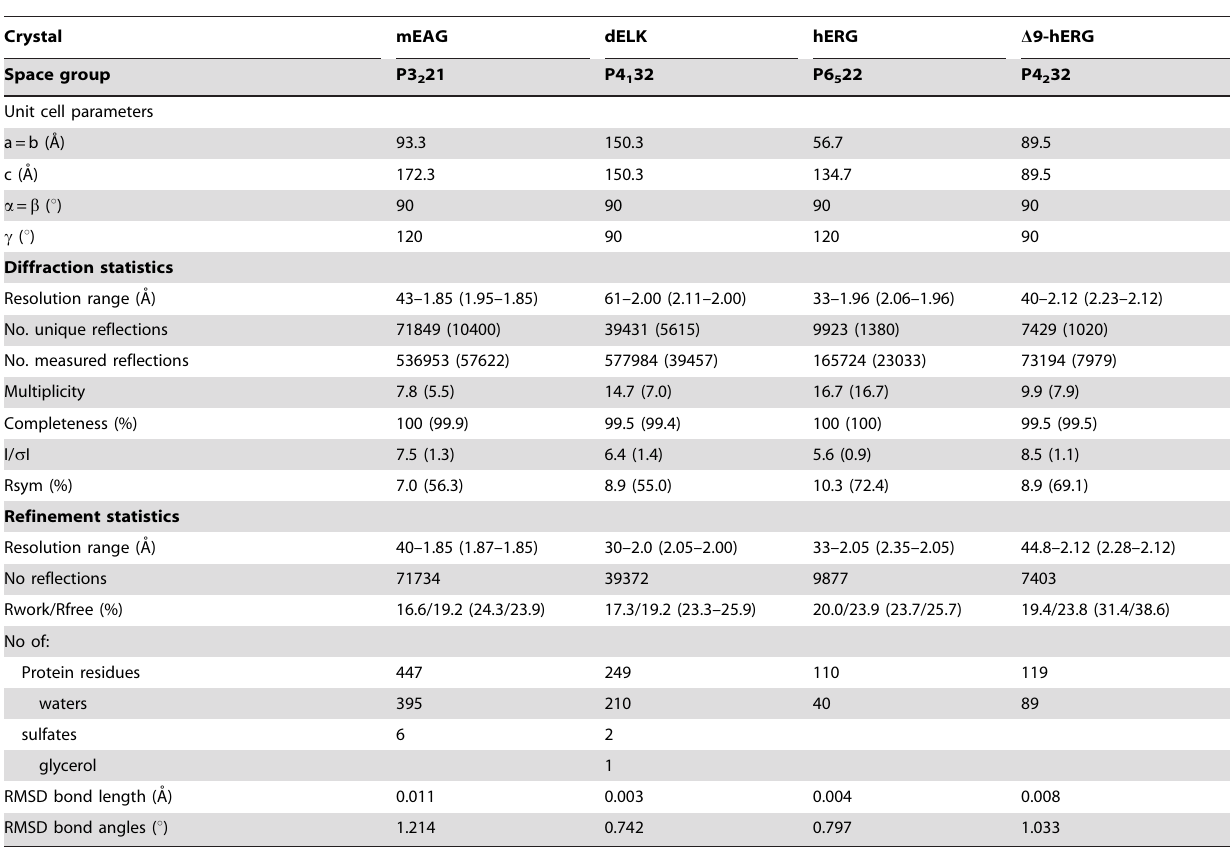
Table 1. Crystallographic data and refinement statistics.